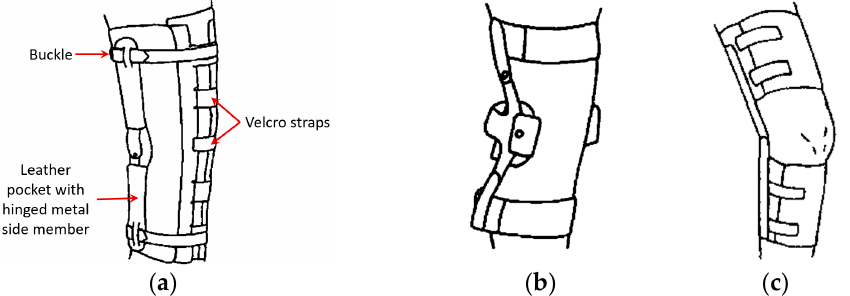
Figure 2. ( a ) Cinch orthosis, ( b ) Swedish knee brace, and ( c ) Custom orthosis with hinged crossbars [11].